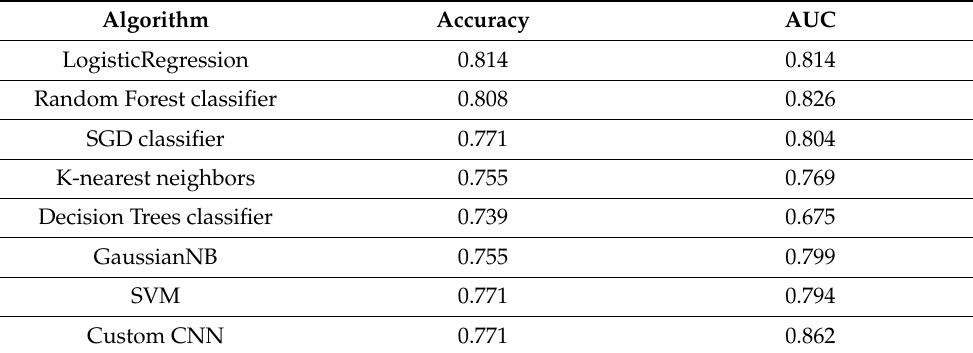
Table 3. Performance measures for the machine learning and deep learning algorithms to predict the length of hospital stay class (binary classification task). Analysis was done with k-fold cross-validation (k = 5). AUC: area under the curve; Accuracy: (TP + TN)/(TP + TN + FP + FN).